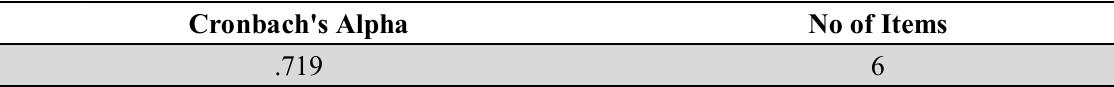
Reliability Statistics for Firm Size